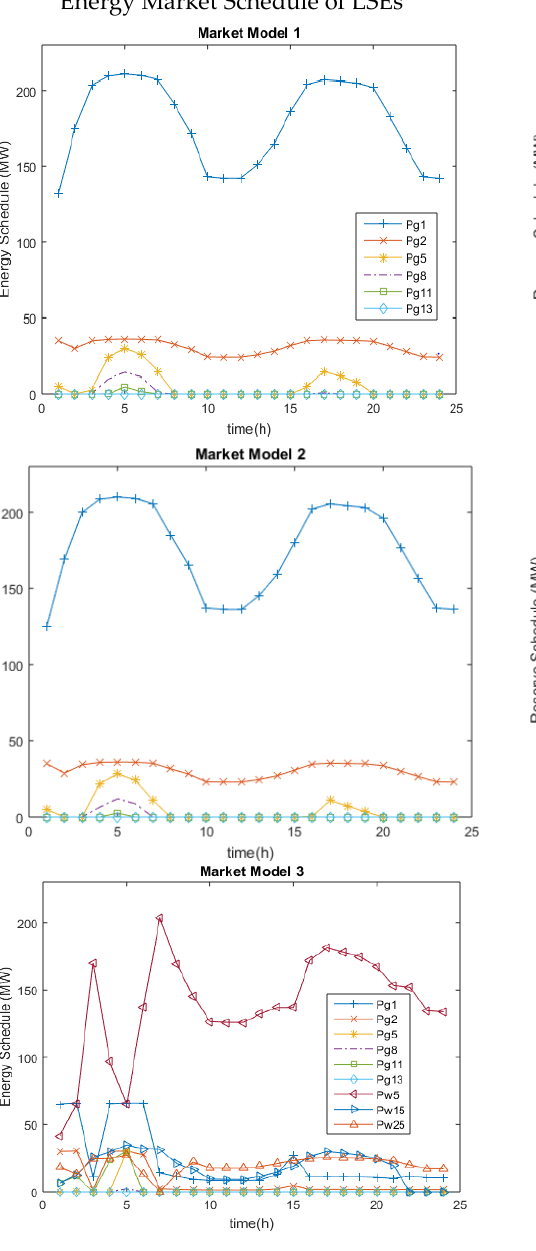
Figure 1. Energy and reserve schedules of LSEs.